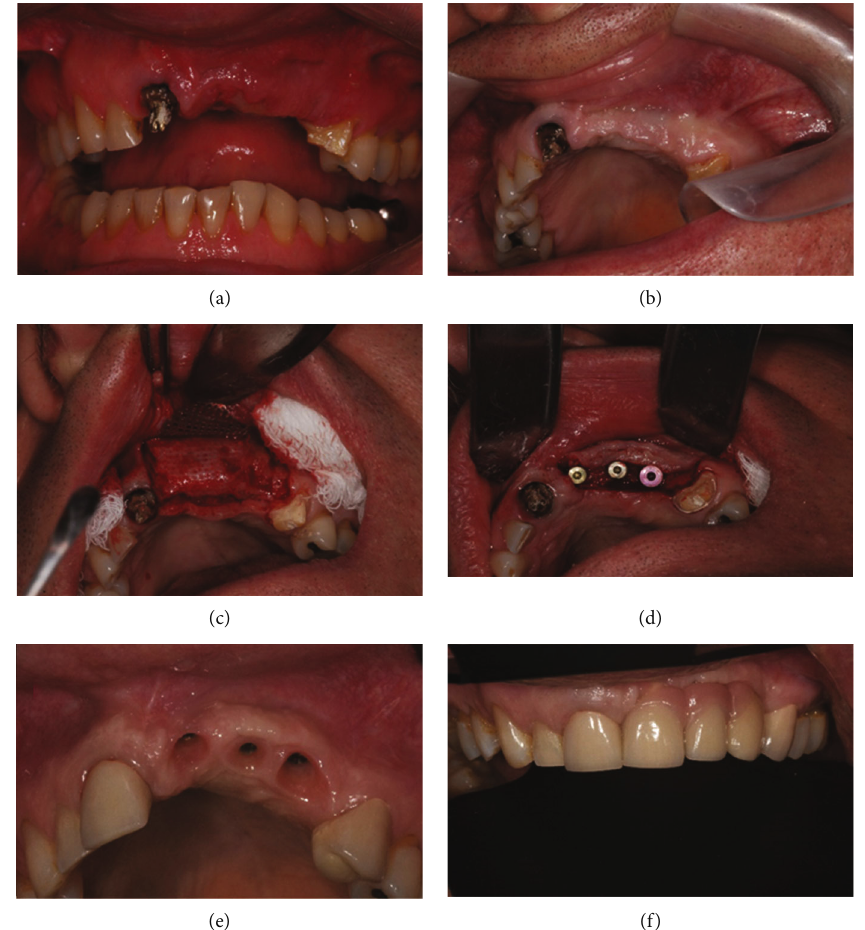
Figure 3: (a) Buccal visualization of the bone contour. (b) Bone and gingival contour. (c) Titanium mesh removal surgery. (d) Placement of Straumann implants. (e) Implant follow-up. (f) Permanent denture placement.